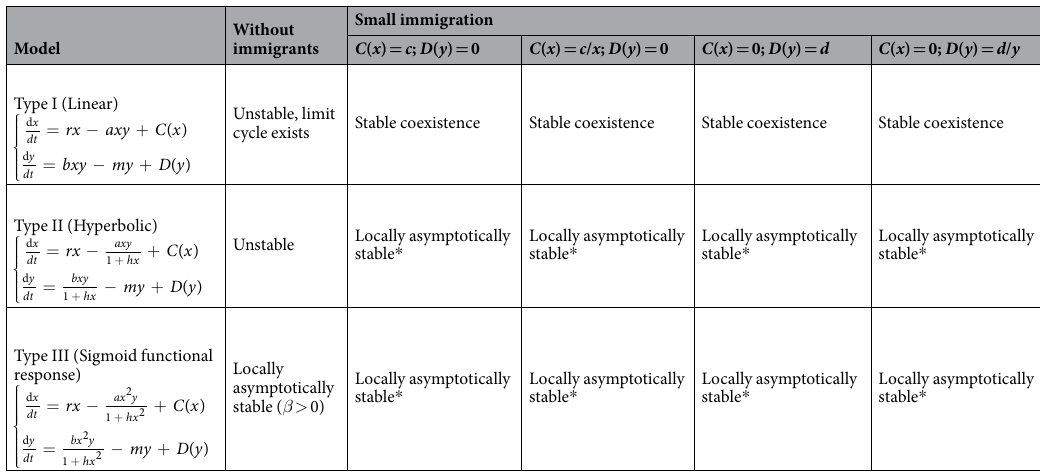
Table 1. Nature of equilibria of Lotka-Volterra system (4) (refer to Supplementary information for the analytical solution). β